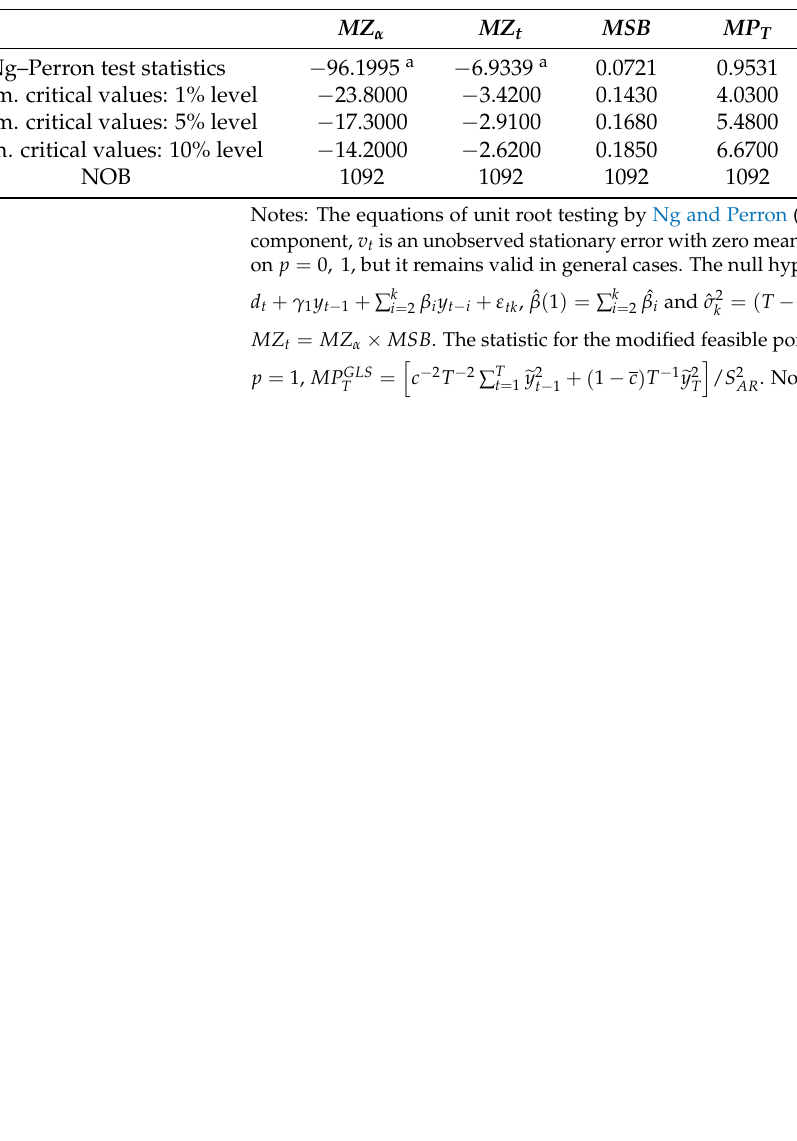
Table 4. Unit root tests: Ng–Perron test.